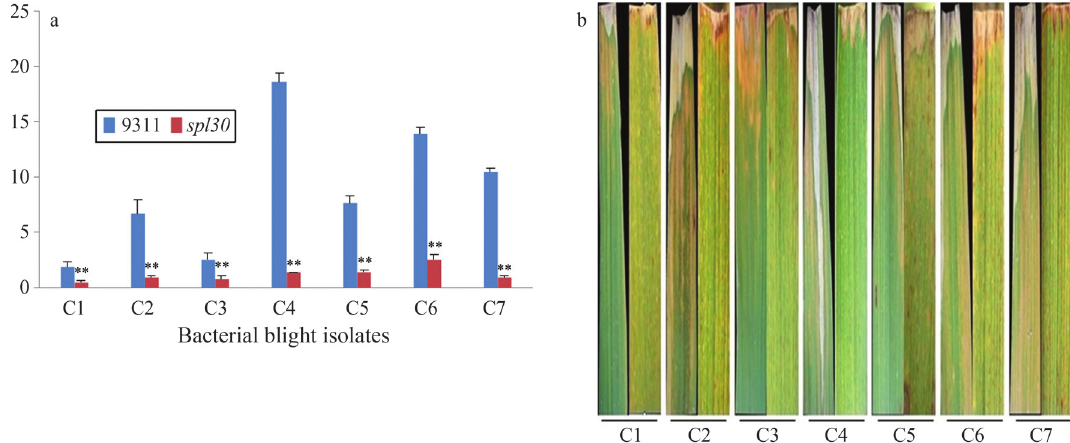
Figure 5 - Analysis of lesions in leaves of wild-type and spl30 plants after inoculation with bacterial blight isolates. (a) Lesion length in wild-type and spl30 plants. (b) Phenotypes of leaves from wild-type and spl30 plants (from left).